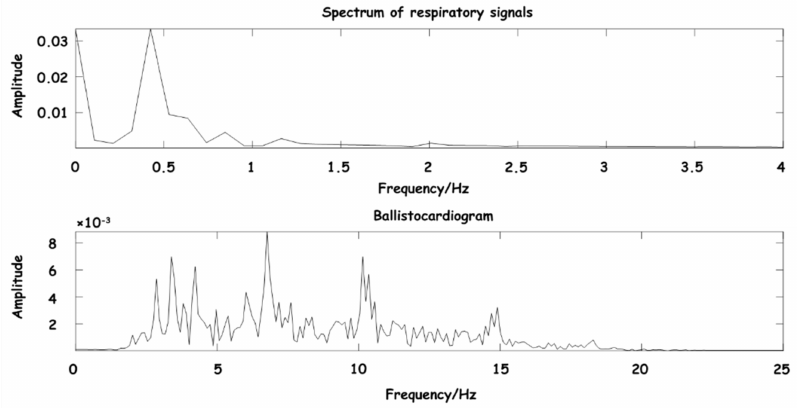
Figure 9. Spectrum diagram of separated